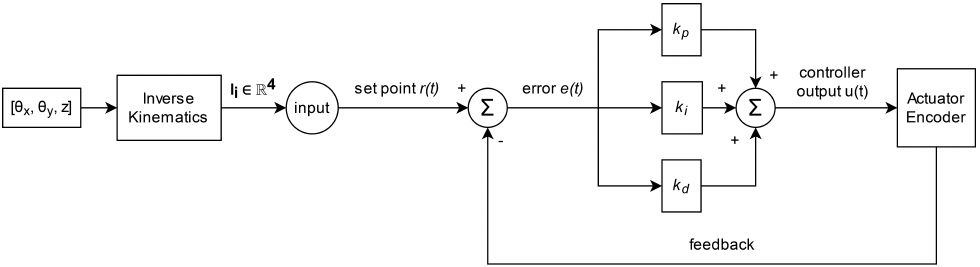
Figure 11. Control system of the 4-UPR